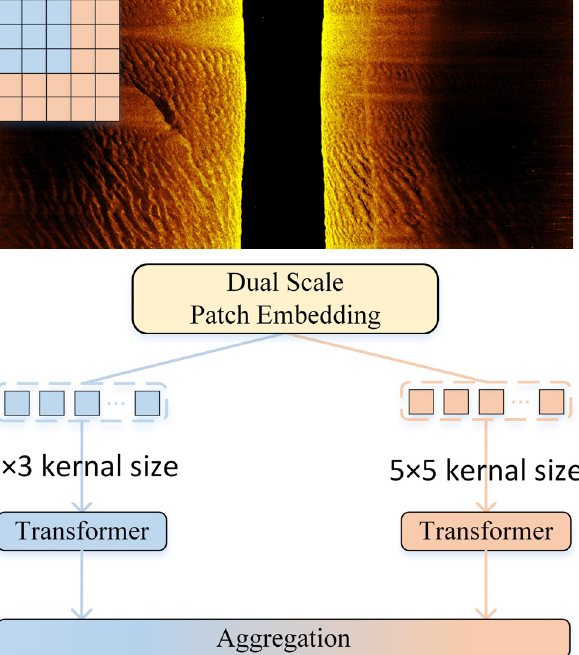
Figure 2. The dual path structure shows that each embedded patch will enter an independent trans- former block. transformer